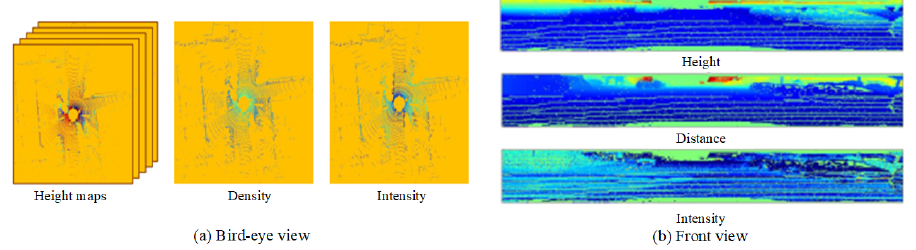
Figure 8. The projected images with different views of a point